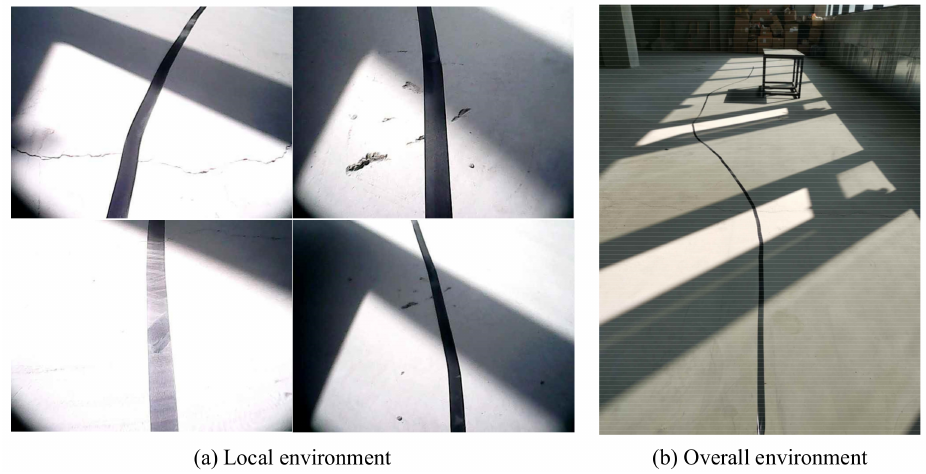
Figure 14. “Double line shifting” test